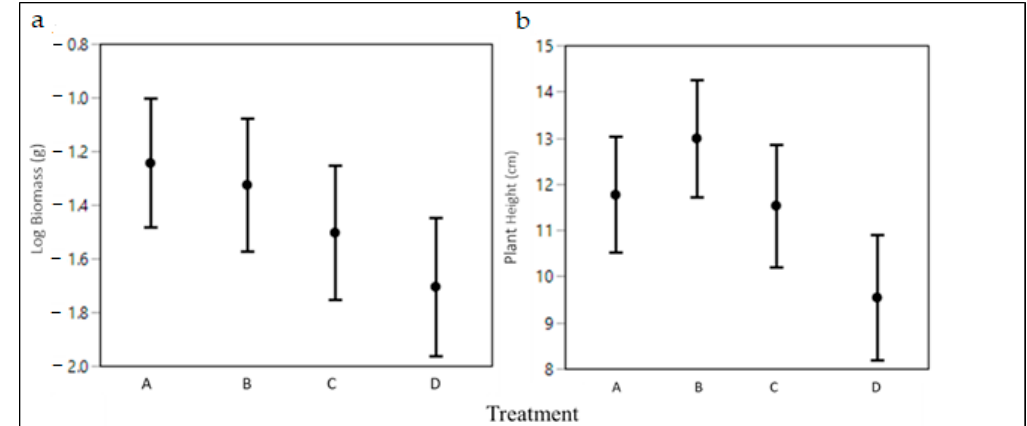
Figure 3. Growth metrics of poison ivy ( Toxicodendron radicans ) plants after two years growing in varying levels of herbi- vore protection: (A) full exclusion (no herbivory), (B) small mammal exclusion that also included large mammal exclusion; (C) large mammal exclusion only; and (D) no exclusion. ( a ) Natural log biomass across exclusion treatments (LS means ± 95% CI’s). ( b ) Plant height across exclusion treatments (LS means ± 95% CI’s).